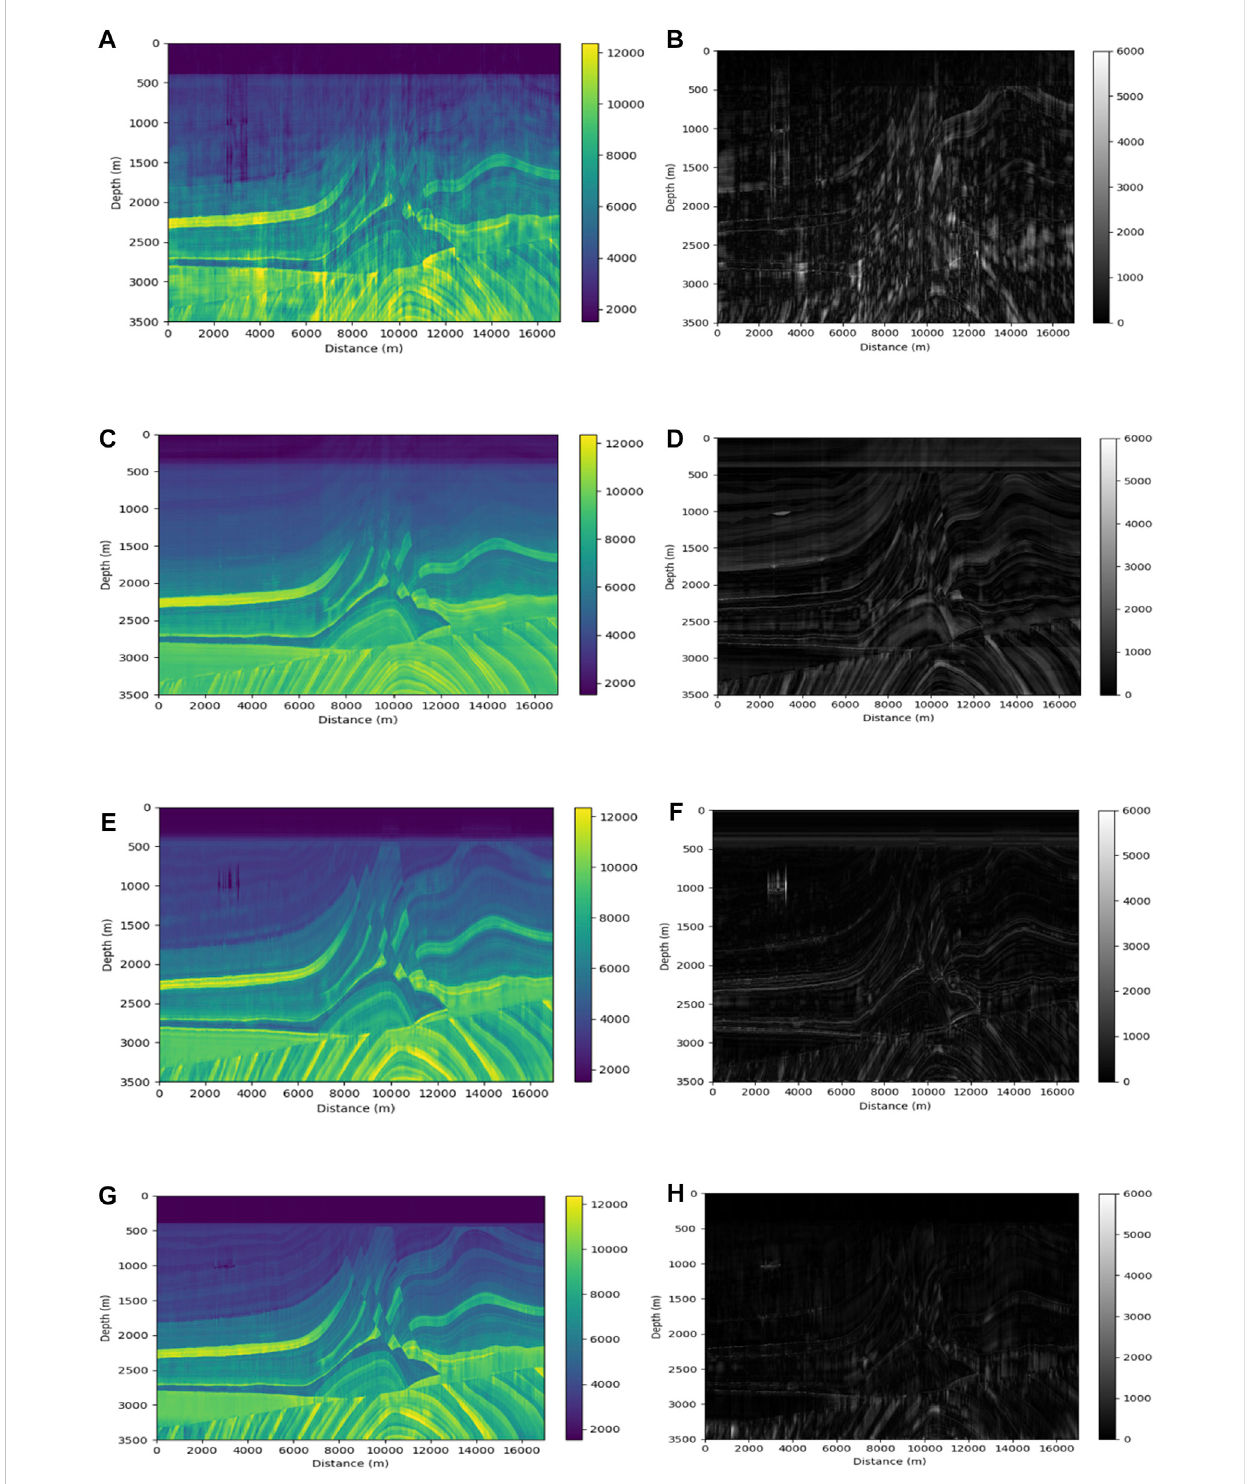
FIGURE 6 Acoustic impedance inversion pro fi les and residual pro fi les on the Marmousi2 model. (A) Inversion result of CNN method and its residual (B) . (C) InversionresultofTCNmethodanditsresidual (D) . (E) InversionresultofU-Netmethodanditsresidual (F) . (G) Inversionresultofthemethodinthispaper and its residual (H)